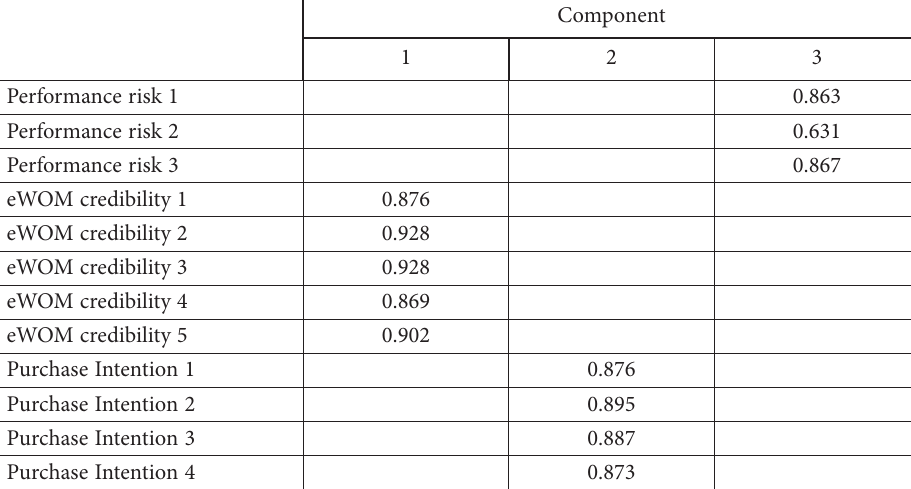
Table 2. Factor analysis results for performance risk-based neWOM